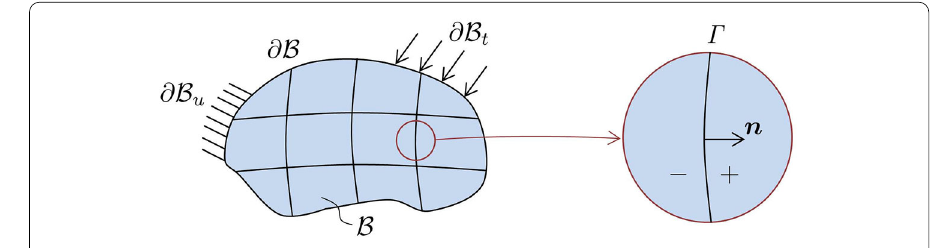
Fig. 1 Discontinuities within the body